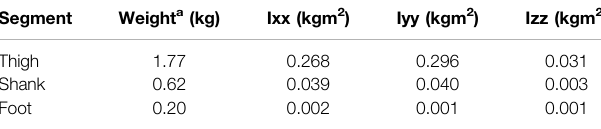
TABLE 1 | Mass properties of the exoskeleton.